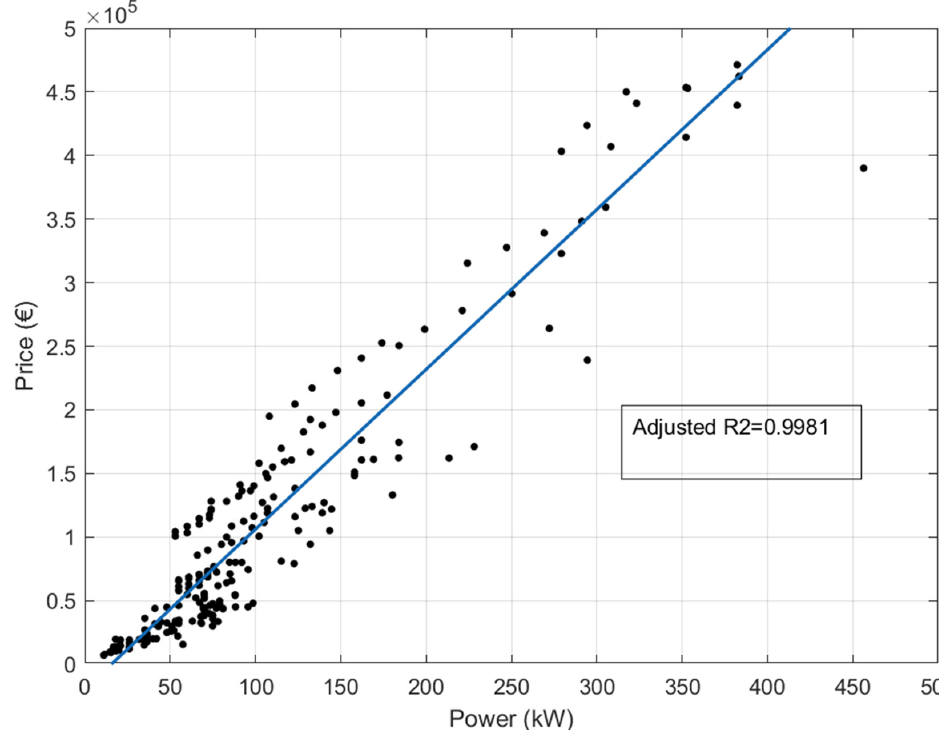
Figure 2. Linear regression using the whole new tractor dataset.